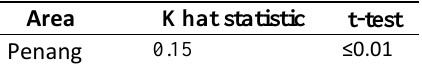
Table 6. Accuracy assessment of